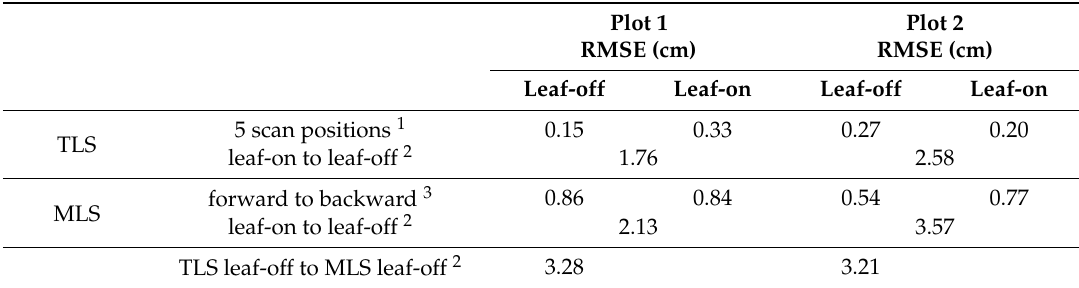
Table 2. Accuracies of the MLS and TLS co-registration. 1 plane-to-plane distance; 2 ICP with 3D point-to-point distance; 3 3D point-to-point distances. Plot 1 Plot 2 RMSE (cm) RMSE (cm) Leaf-off Leaf-on Leaf-off Leaf-on 5 scan positions TLS